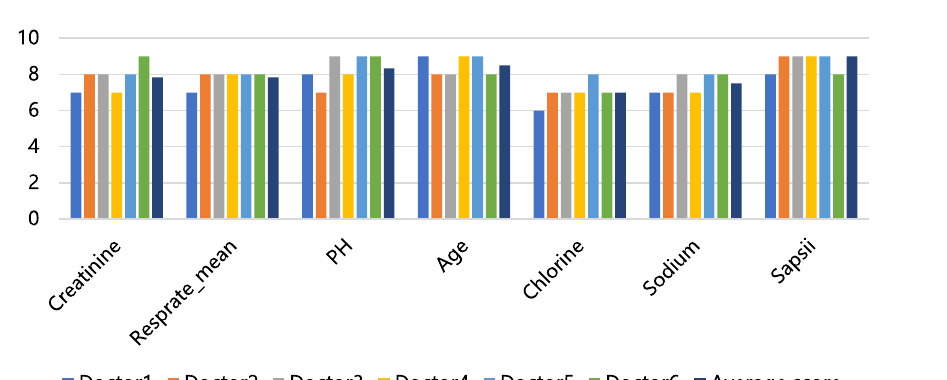
Figure 6. Doctor’s evaluation of the results of model